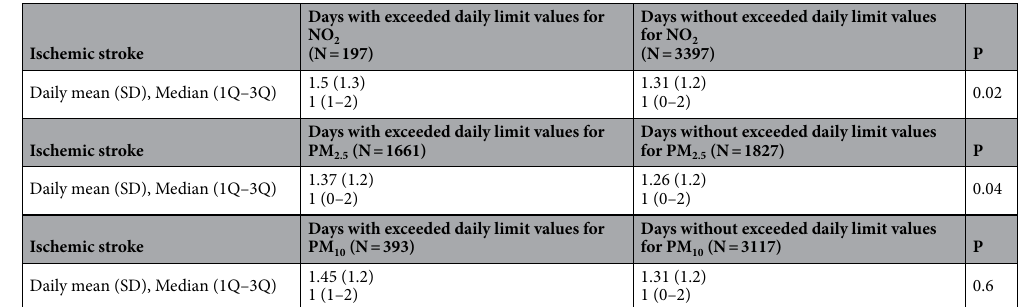
Table 5. The comparison of the frequency of hospitalizations due to ischemic stroke on the days with and without exceeded daily norms recommended by the World Health Organization for nitrogen dioxide, particulate matter with a diameter of 10 μm or less, and particulate matter with a diameter of 2.5 μm or less. NO 2 , nitrogen dioxide; PM 2.5 , particulate matter with a diameter of 2.5 μm or less; PM 10 particulate matter with a diameter of 10 μm or less; SD, standard deviation.